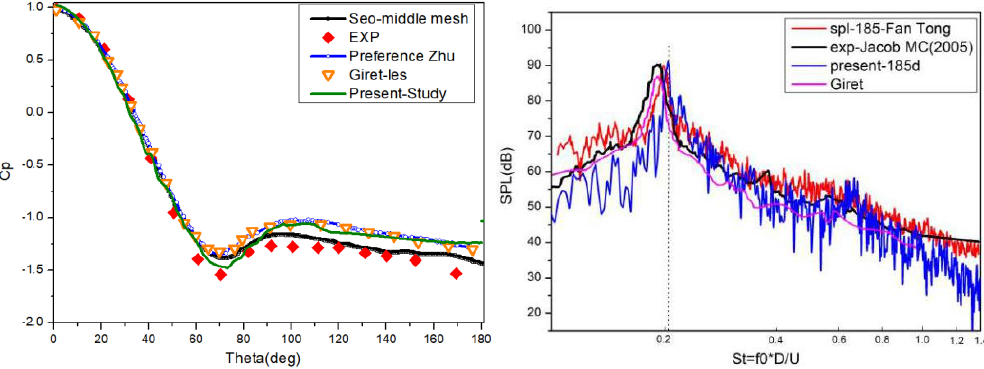
Figure 9. Vortex shedding on plane at 50% span(s − 1 ). Figure 9. vortex shedding on plane at 50% span(s −1 ). Figure 9. vortex shedding on plane at 50% span(s −1 ).